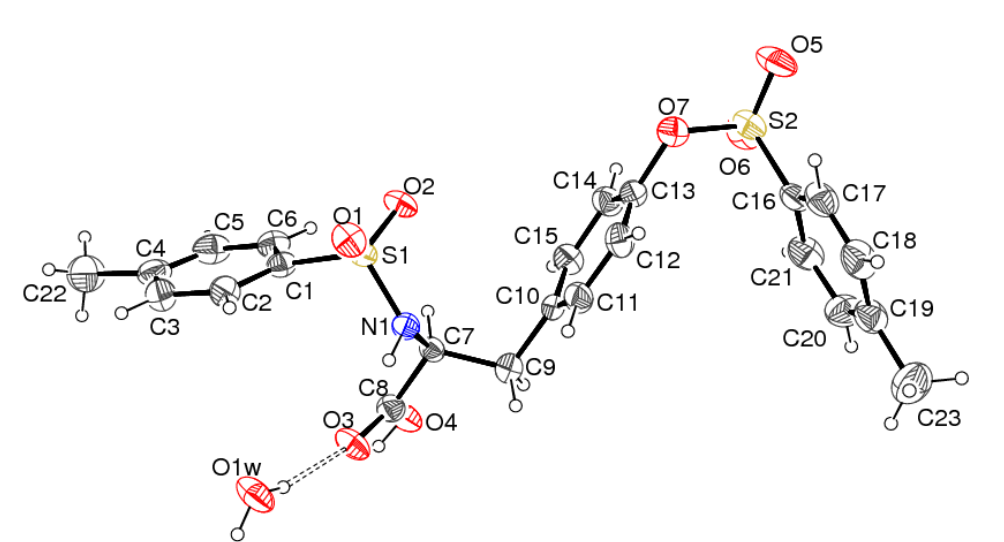
O showing 40% displacement ellipsoids. The O– 2